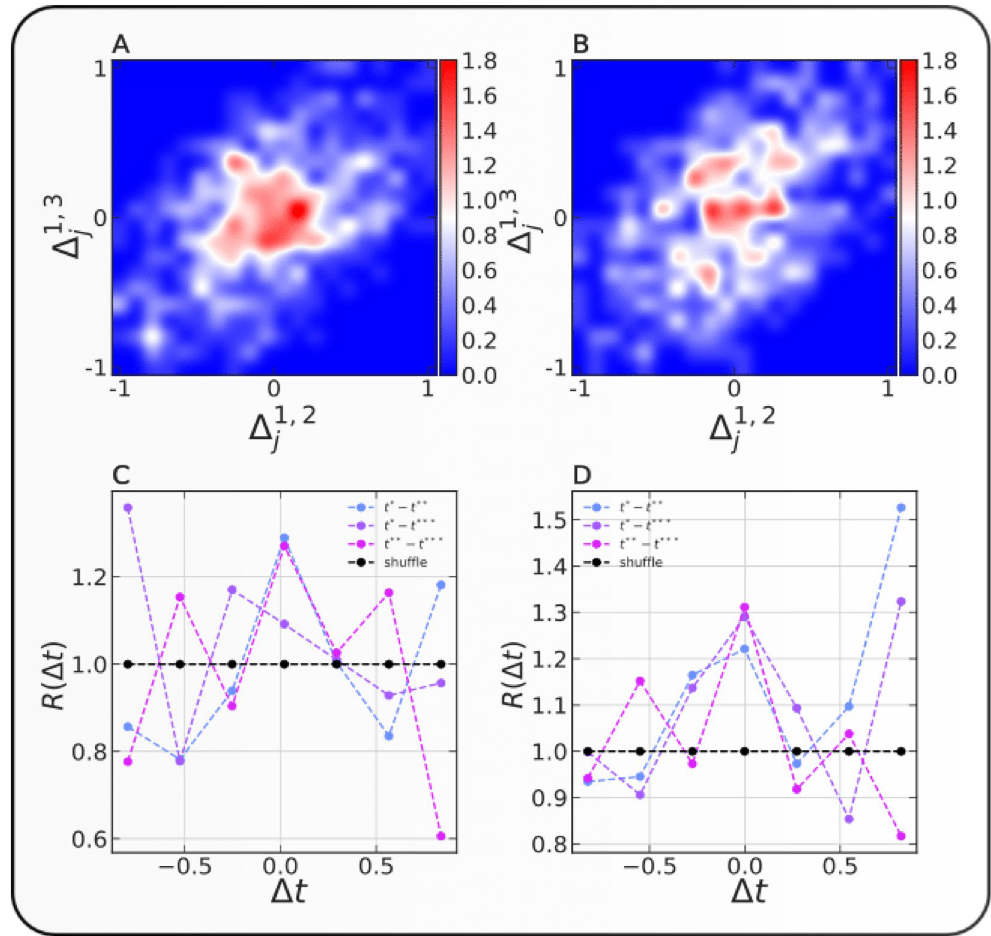
1,2 , � 1,3 ) and R (� t ) . ( A , B ) show the joint distribution of the j j 1,2 , (cid:31) 1,3 , (cid:31) 2,3 j j j . ( A , C ) correspond to the batting performances in ODI